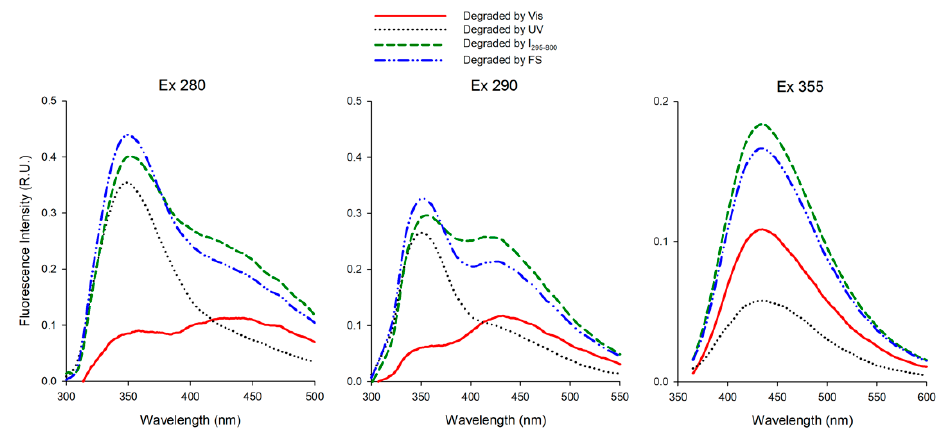
Figure 4. Hypothetical emission spectra of the compounds that were degraded by irradiation. For each treatment the spectrum shown is the average spectra of the replicates. Note the difference in the scale of both axes.